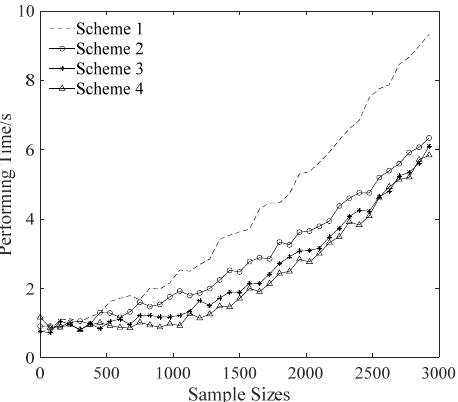
Figure 9. Total performing time of each scheme under different total sample sizes on the FPGA platform.